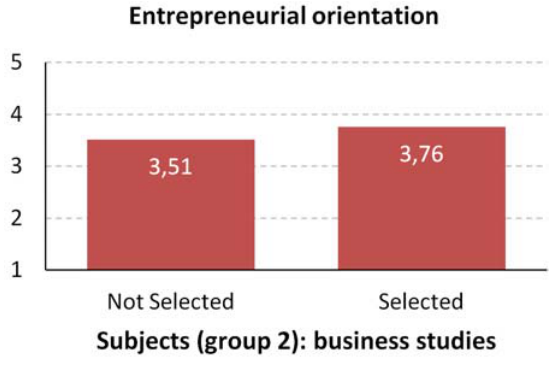
Fig. 1. Hypothesis testing one – mean score